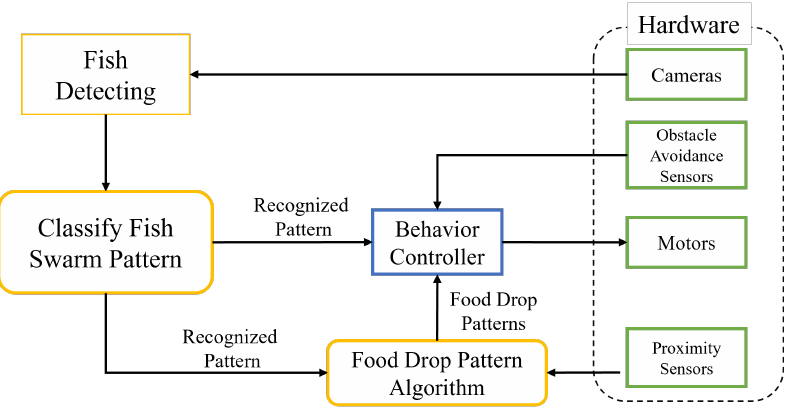
Figure 5. The simplified software architecture of the robotic fish is illustrated with the use of color coding, where sensors are represented in green, algorithms in yellow, and robot behaviors in